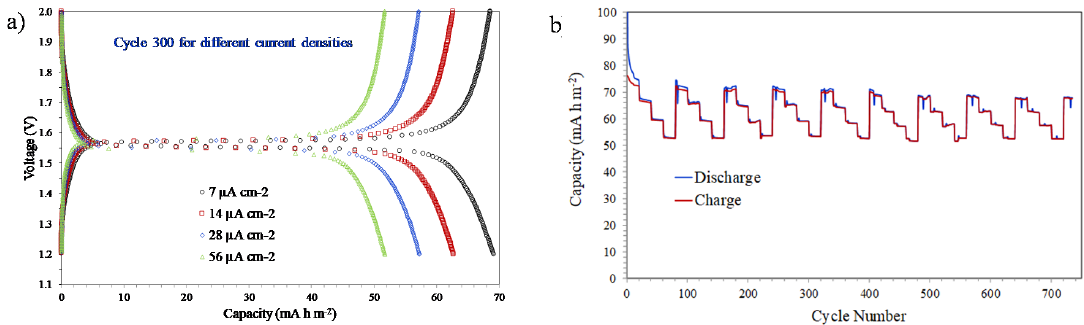
Figure 10. Galvanostatic discharge-charge test at different current densities (7, 14, 28, 56 µA cm −2 ) of a sample treated at 700 °C: ( a ) capacities vs. voltage curves of the cycle 300 for different current densities, and ( b ) cycle number vs. capacities curves with 20 cycles at each current density.